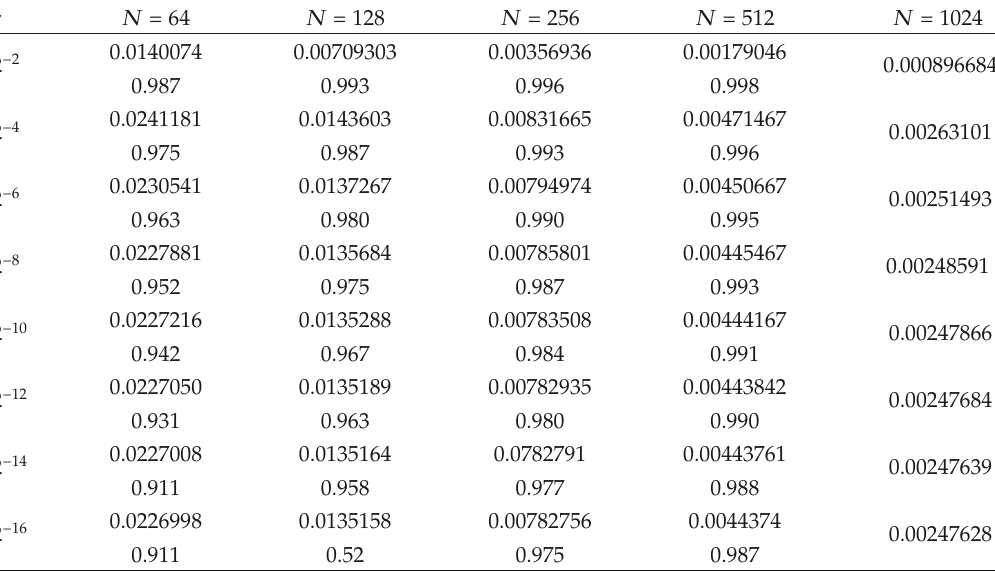
Table 3: Maximum Errors and Rates of Convergence for the Bakhvalov Mesh on ω